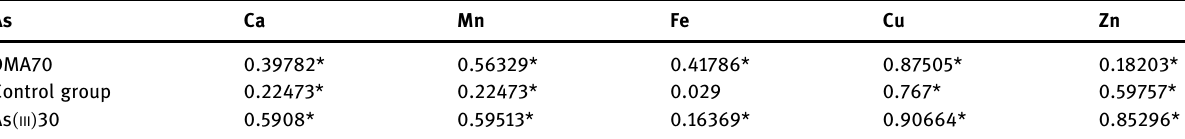
Table 1: Pearson coe ffi cient ( R ) of correlation between As and other elements in honeysuckle roots As Ca Mn Fe